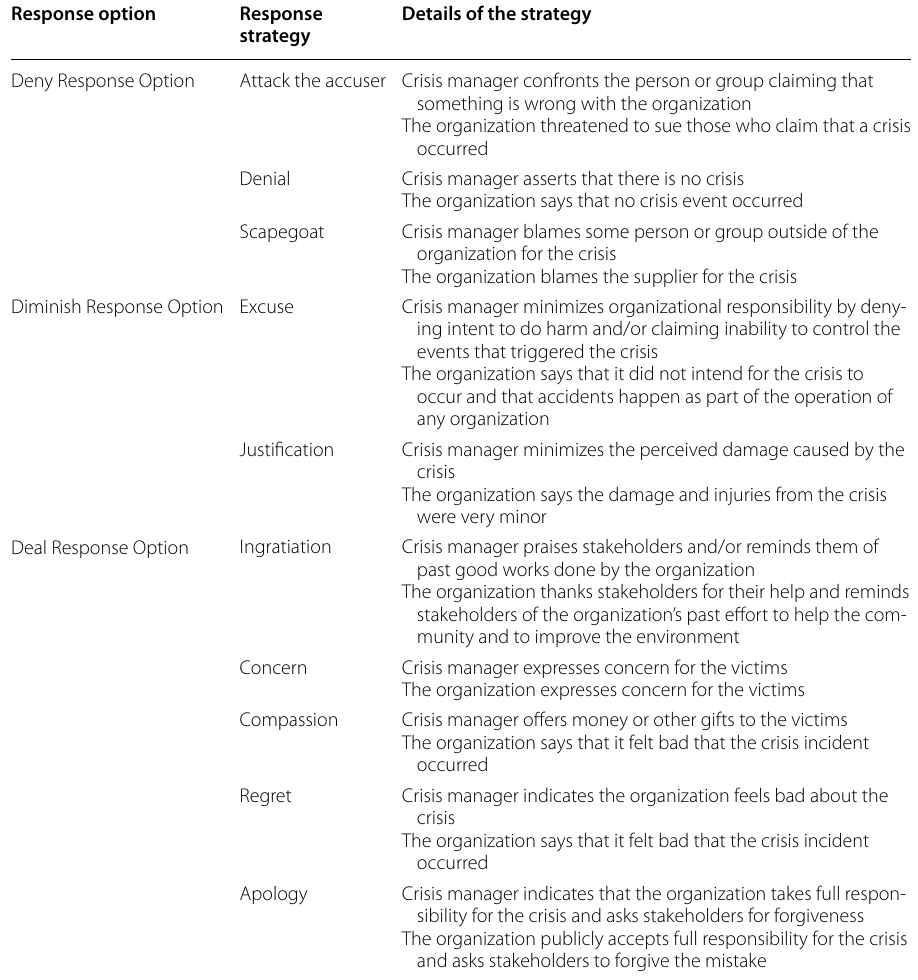
Table 3 Crisis response strategies of Situational Crisis Communication Theory (Coombs, 2006, p. 248 [see Table 2 in the original